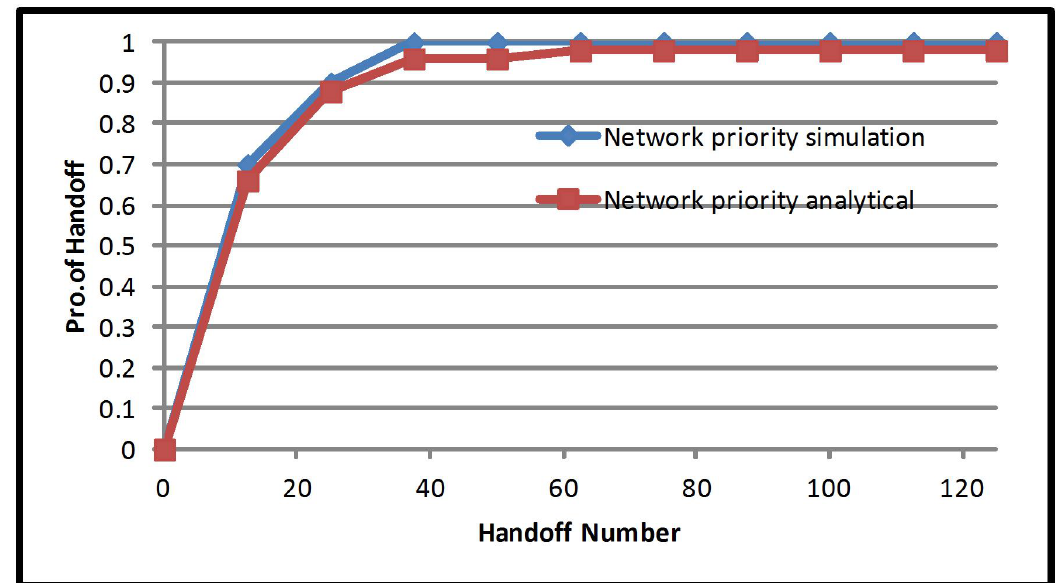
Figure 9. Handoff number